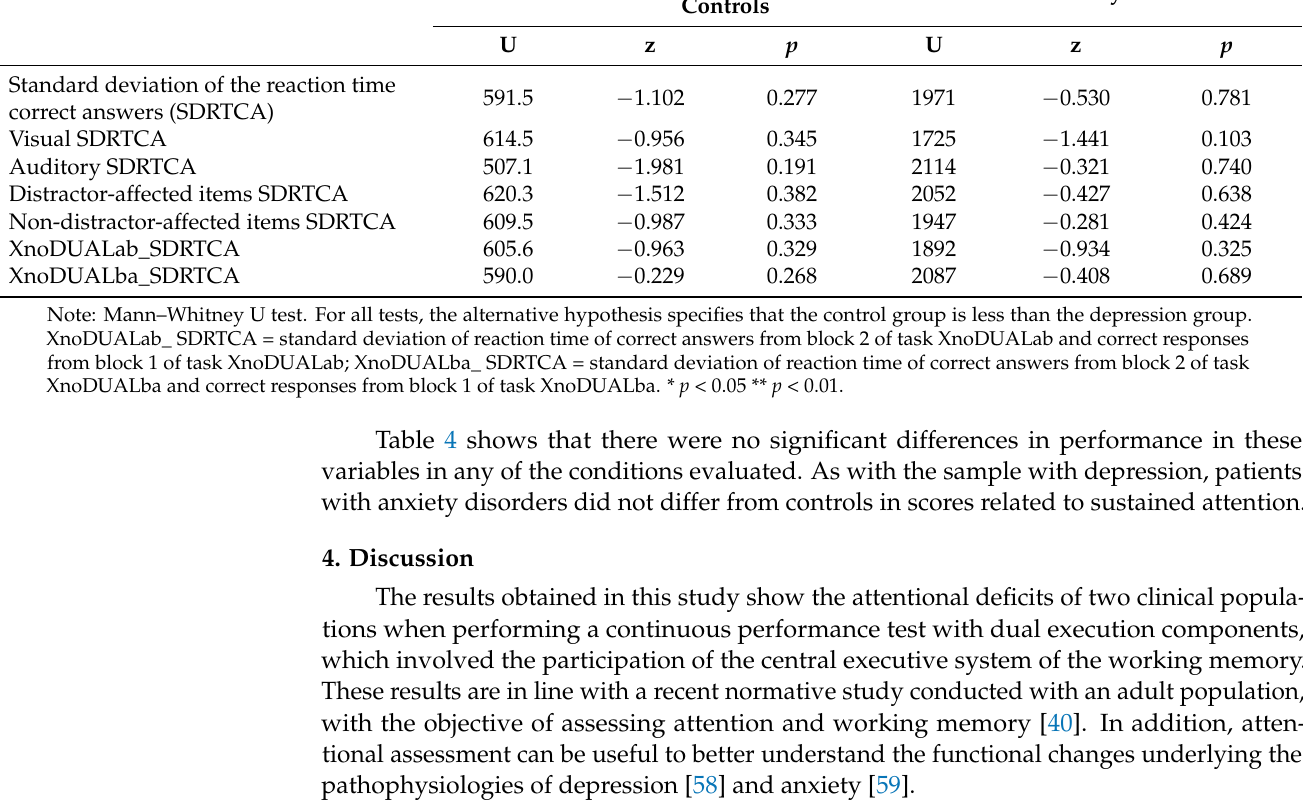
Depression and Controls